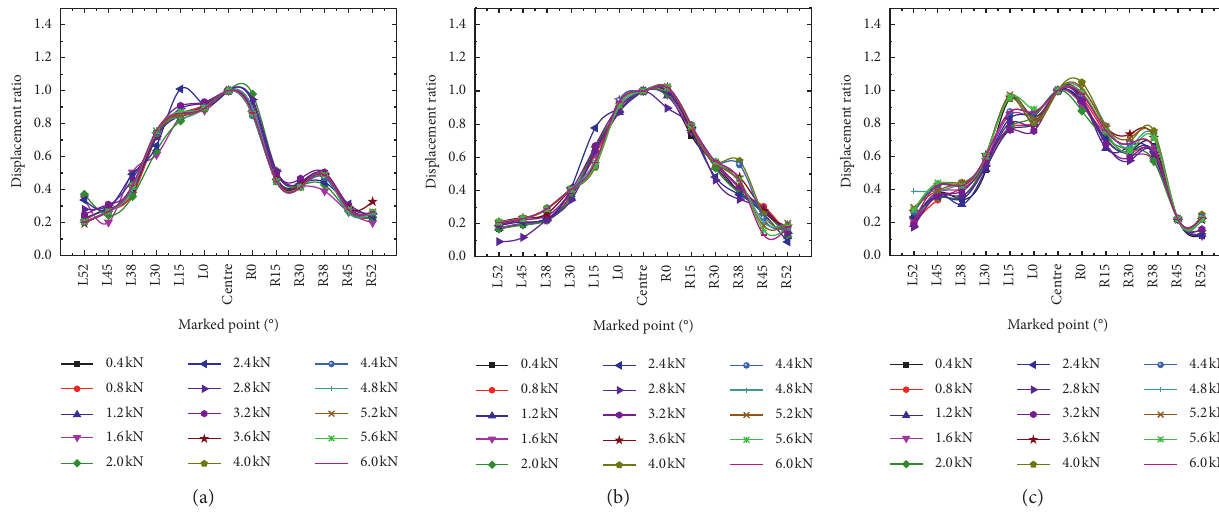
Figure 16: Distribution curve of soil displacement according to diffusion angle under different loads at 15 ° . (a) The 0 b row. (b) The 0.75 b row. (c) The 1.50 b